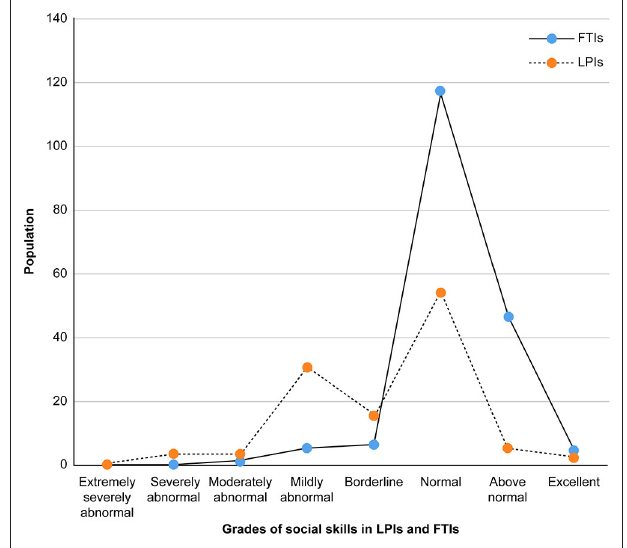
FIGURE 1 | Distribution of grades of social skills in LPIs and FTIs.